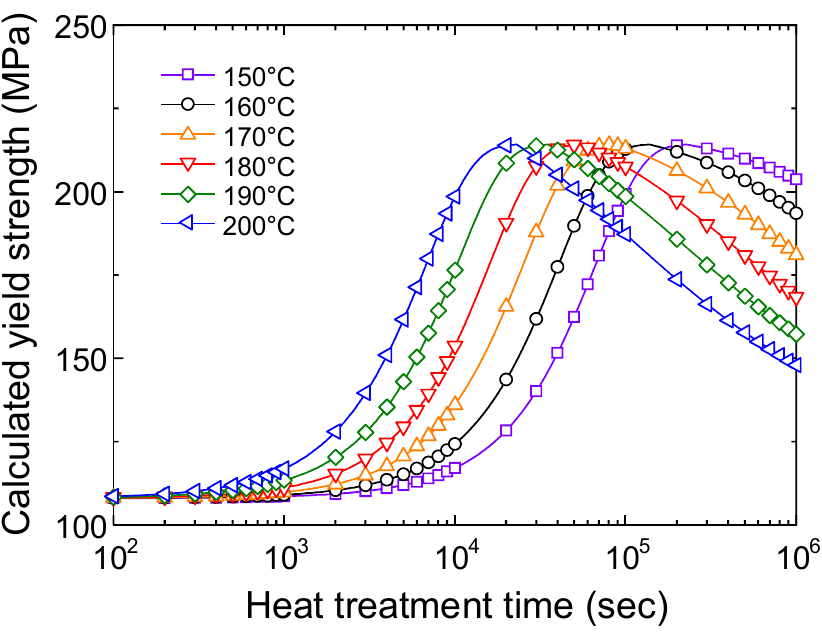
Figure 14. Calculated yield strength changes at arbitrary heat treatment temperature